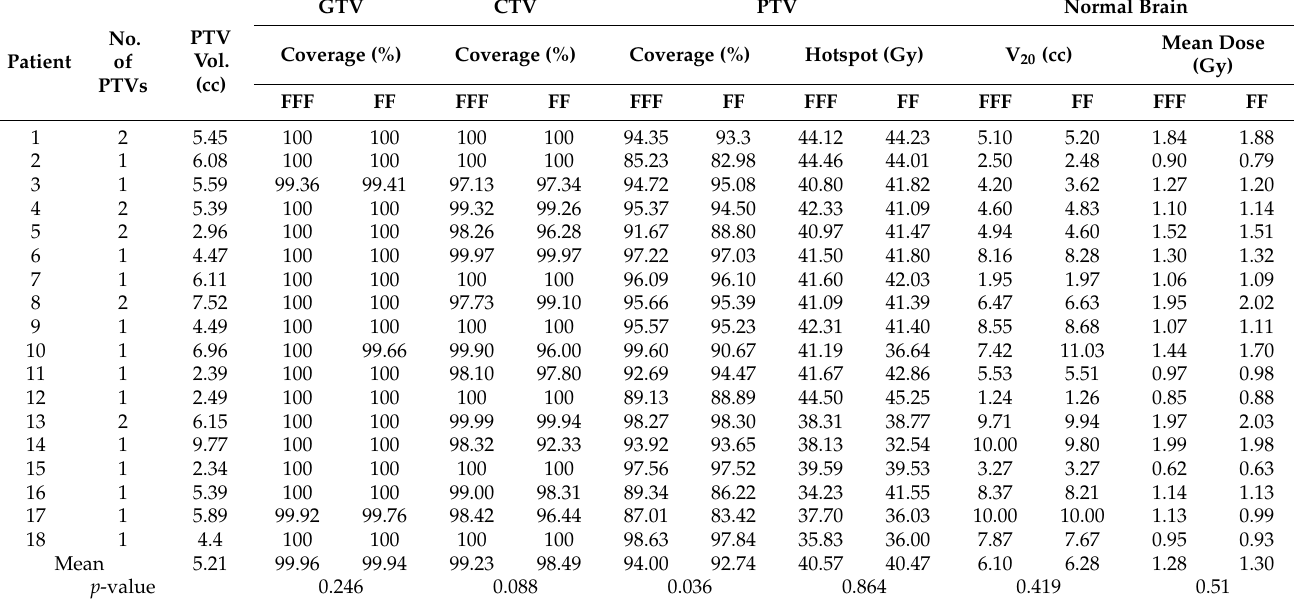
Table 5. Dosimetric evaluation for PTVs and